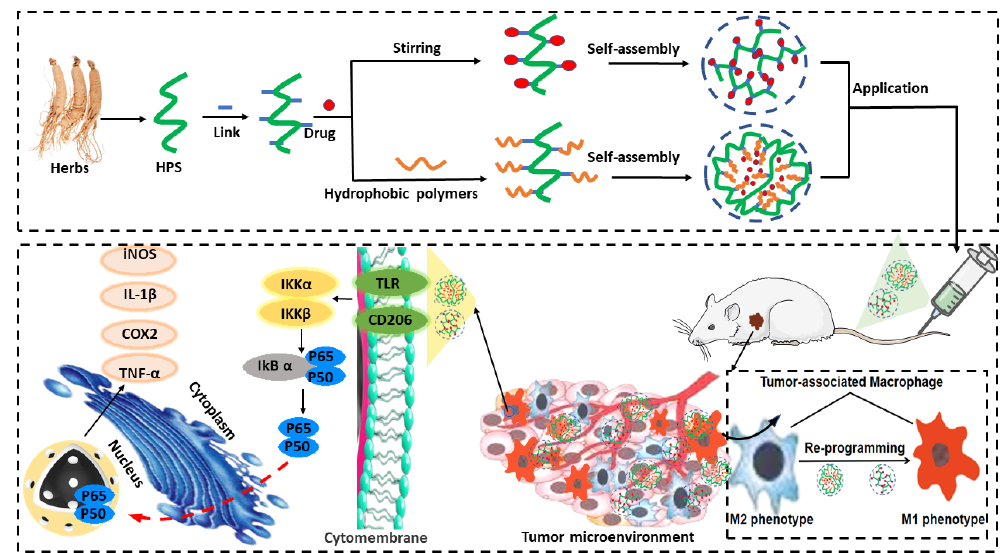
Figure 1. Fabrication and application of HPS amphiphilic derivatives.